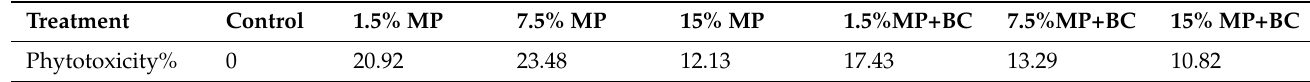
Table 3. Biochar effect on the phytotoxicity of soil microplastic on Vicia faba roots.